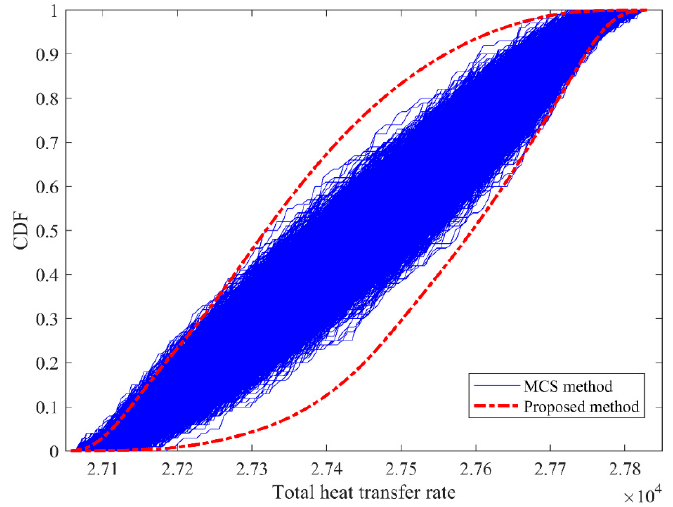
Figure 10. Uncertainty analysis results of the heat exchanger.